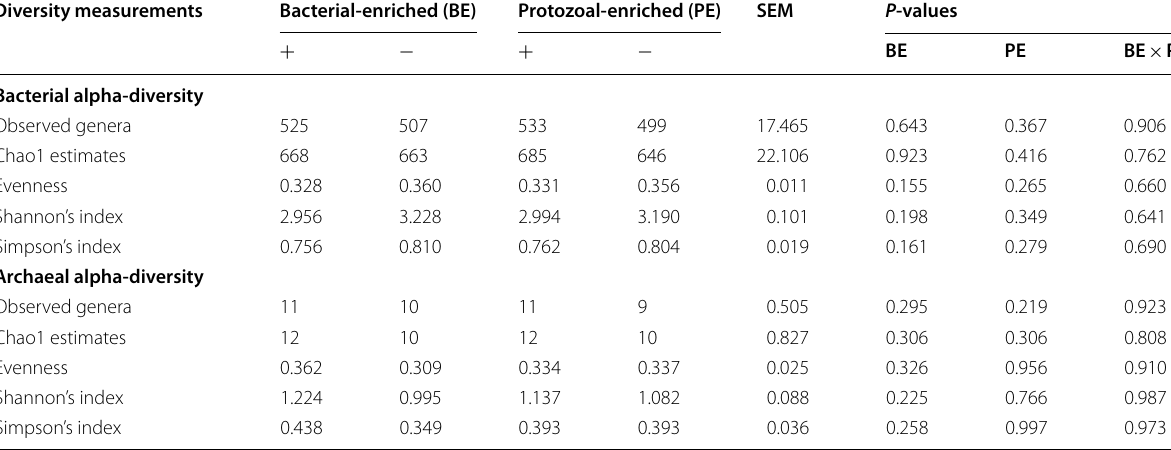
Table 1 Alpha diversity measurements in microbial inoculation treatments Diversity measurements Bacterial‑enriched (BE)